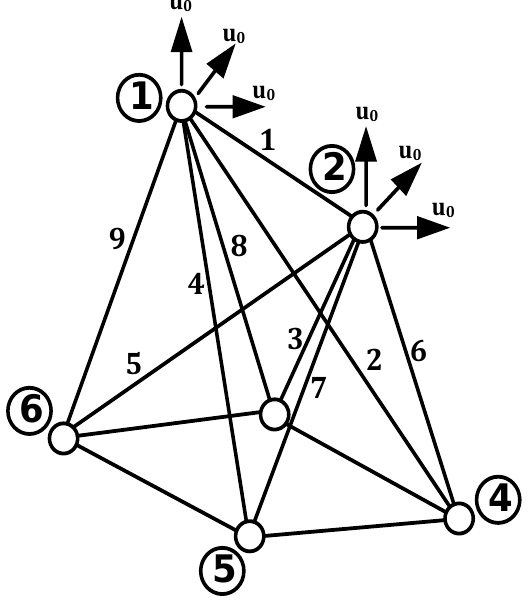
Figure 2. Applied loads at the Nodes {1}, {2}, {3}, {5} and